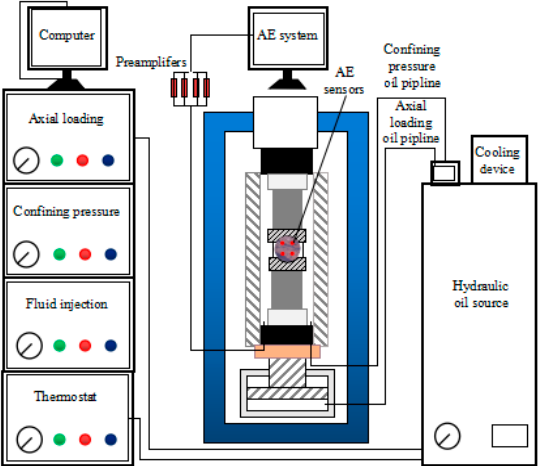
Figure 2. TAW-2000 electro-hydraulic servo rock triaxial testing machine and operation principle. Different loading angles ( θ = 0°, 30°, 45°, 60°, 90°) were used to carry out acoustic